Question: What does this figure show? Answer in one sentence.
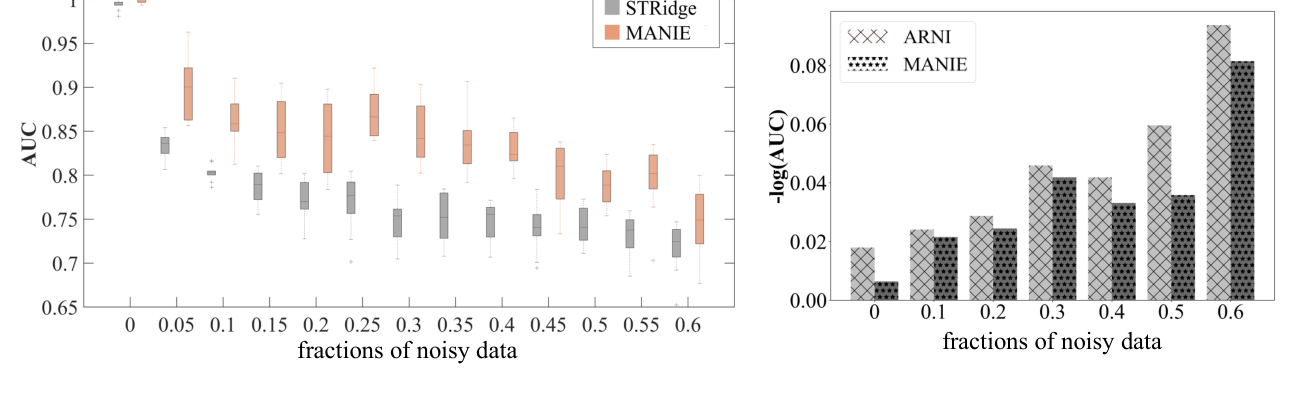
Answer: demonstrates the influence of noise levels on MANIE in the context of ZK network inference. AUC scores for model-based inference from EG data using MANIE with embedded STRidge, (a) varying by the amplitude of random noise while maintaining a 0.5 fraction of noisy data, and (b) varying by the fraction of noisy data while keeping the amplitude of random noise at 10. AUC scores for model-free network inference, (c) dependent on the signal-to-noise ratio (SNR)/dB and (d) influenced by the fraction of noisy data. The EG process underwent 6 repetitions, each encompassing 10 rounds. Model-free data were aggregated through brief transient time series spanning 5 time steps, originating from 50 distinct initial conditions using a Kuramoto-1 oscillator.